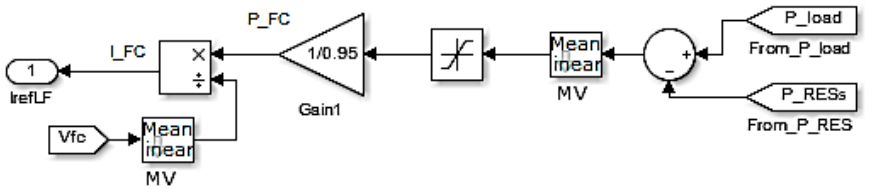
Figure 6. The diagram of the load-following control.